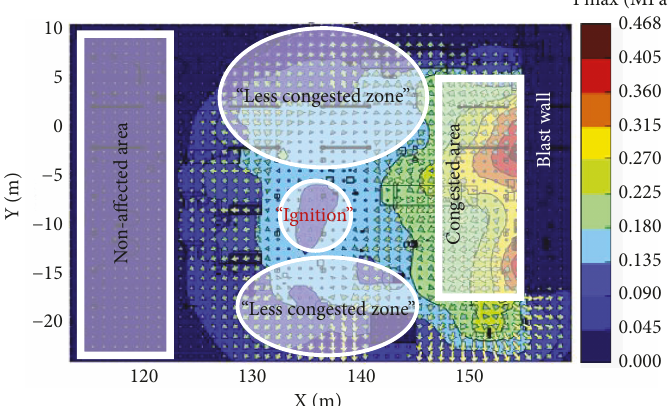
Figure 2: Explosion pressure contour according to wave propagation [18].